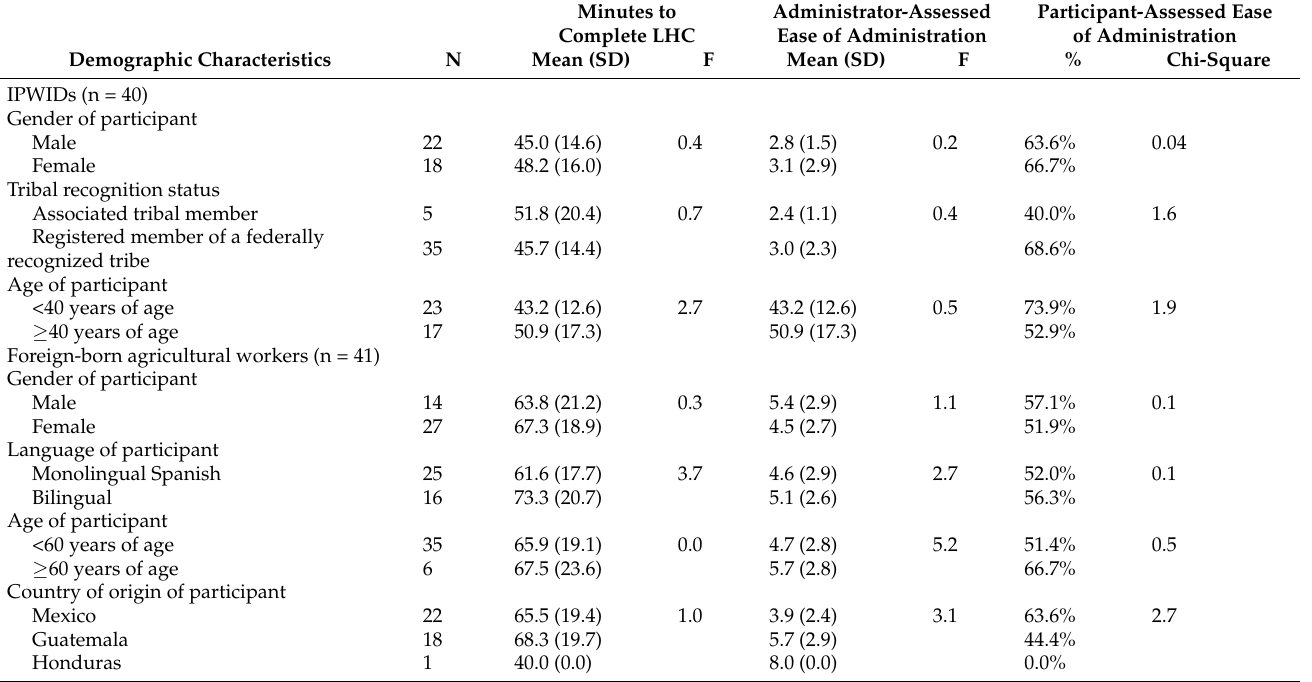
Table 1. Duration and ease of LHC administration relative to the demographic characteristics of the participants of the two pilot studies, n =